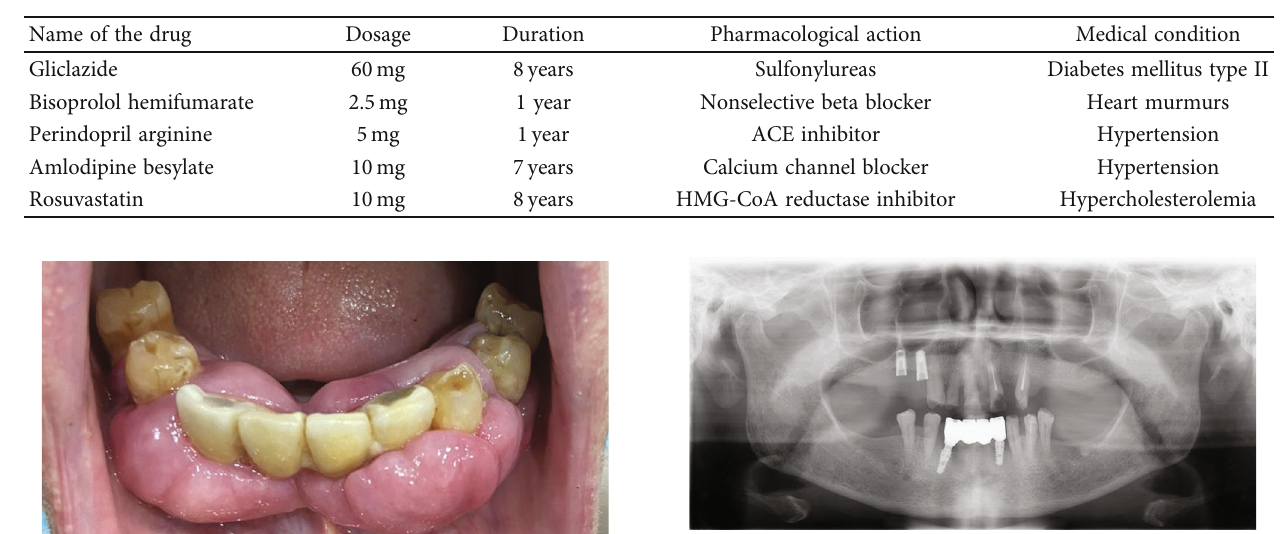
Table 2: Drugs taken by the patient.